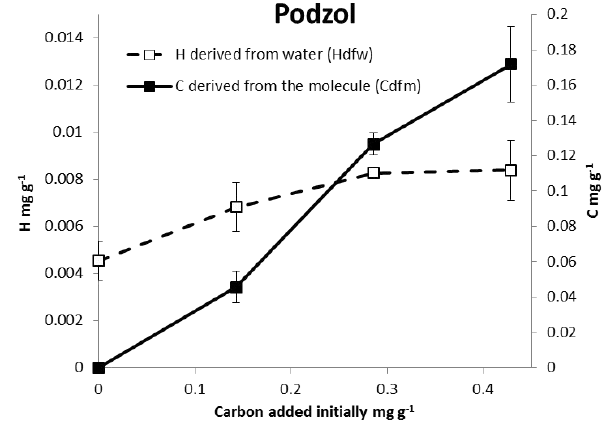
Figure 4. Amount of substrate-derived H and C at 7 days of in- cubation vs. the concentration of substrate as carbon (0.14, 0.29 and 0.43mgg − 1 ) . The concentration C in Experiment 1 is equal to 0.43mgg − 1